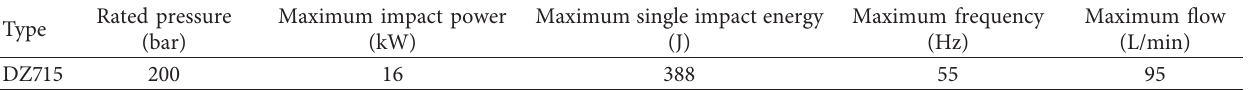
Figure 5: Drilling principle and implementation process on the impact drilling test bed: (a) 3D model of impact drilling test bed; (b) actual impact drilling test bed; (c) drilling process on the test bed; (d) five rock blocks after drilling center holes. Table 1: Performance parameters of the hydraulic rock